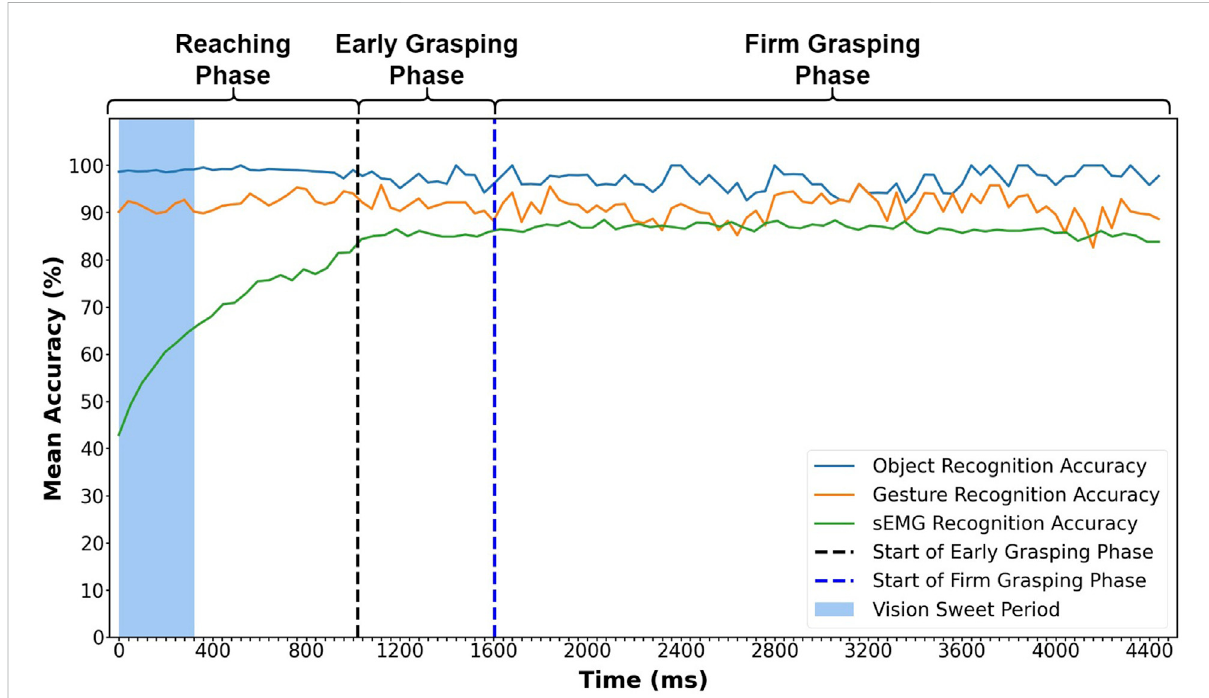
FIGURE 5 Mean accuracy for sEMG, object, and gesture classi fi cation at each time point during the entire grasping process. The object and gesture recognition results are from the trained dual-channel CNN model with leave-one-repetition-out cross-validation among valid frames. The mean accuracyrepresentstheaverageaccuracyof900trialsfrom30subjects.Theresultisalsocalculatedwithleave-one-repetition-outcross-validation.